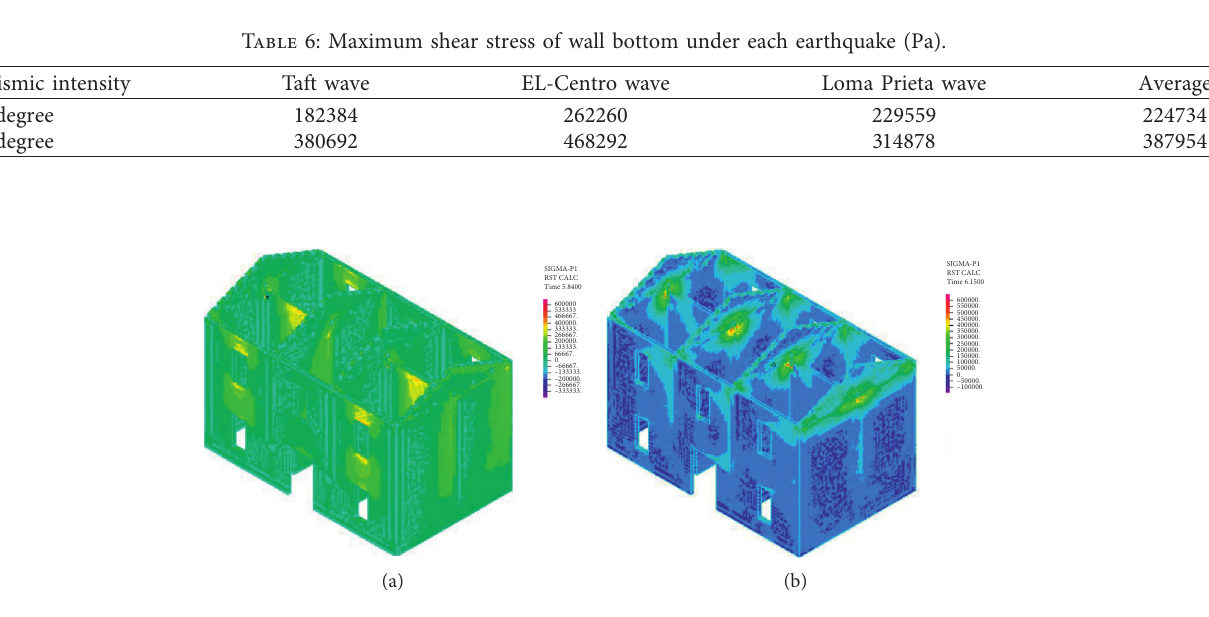
Figure 11: Cloud diagram of the maximum main tensile stress of the wall under Taft earthquake (0.2g). (a) X -direction. (b) Y -direction.